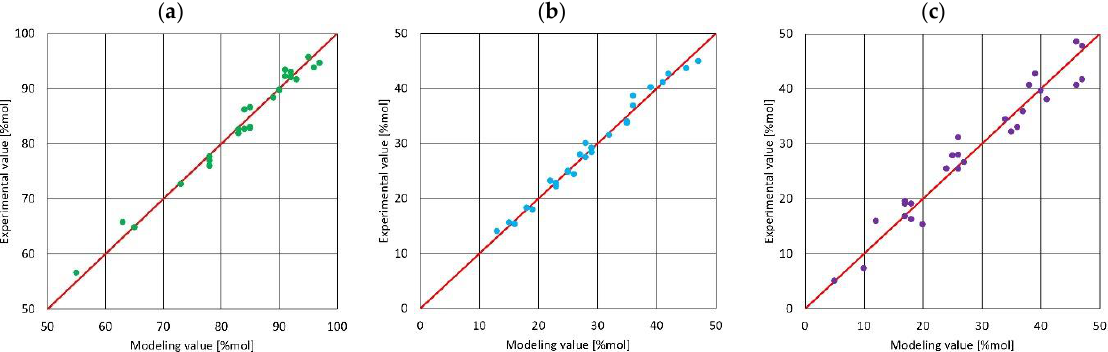
Figure 8. Scatter plots for each output factor: geraniol conversion ( a ), dimethyl selectivity ( b ), and thumbergol selectivity ( c ).